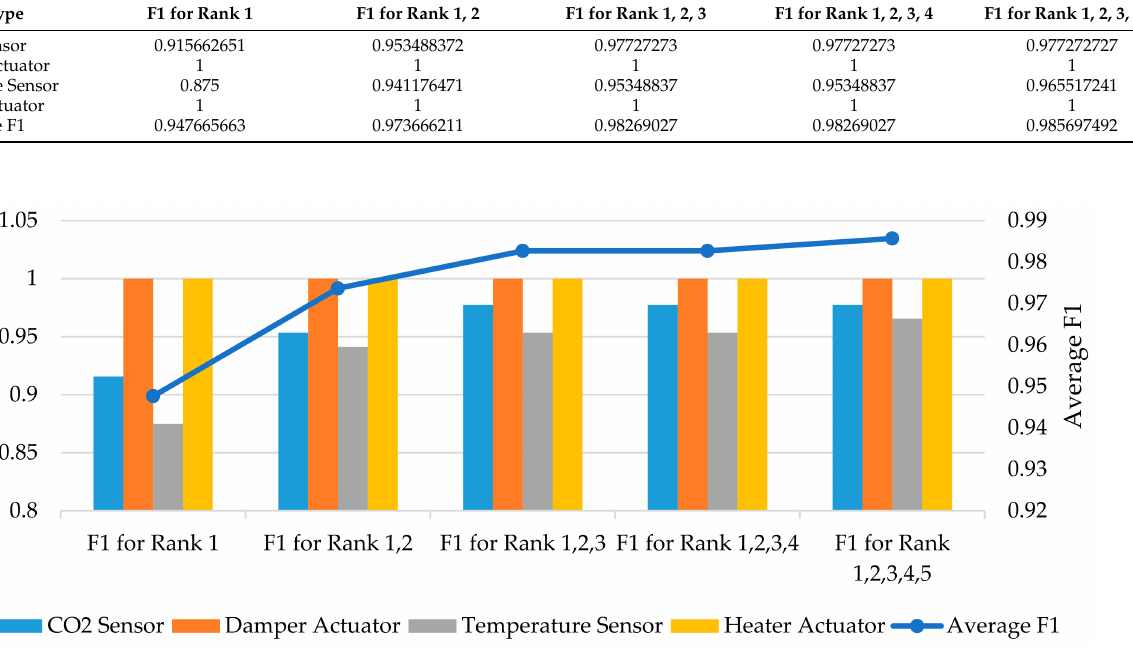
Figure 22. F1 and average F1 in different ranks for different fault